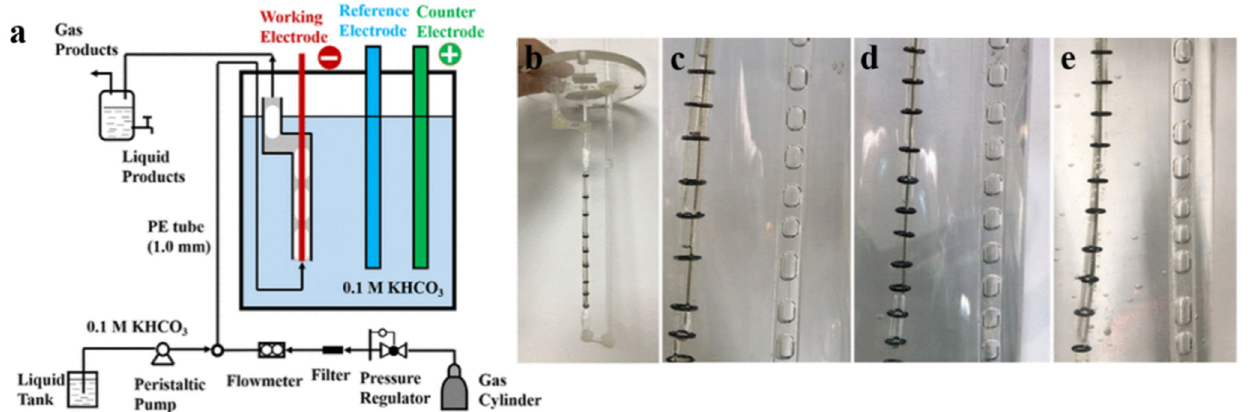
Figure 9. ( a ) Schematic diagram of the microchannel electrolyzer. ( b – e ) Optical images of cylindrical cation-exchange membrane tube. Reproduced with permission from Ref. [136]. Copyright 2020 American Chemical Society.